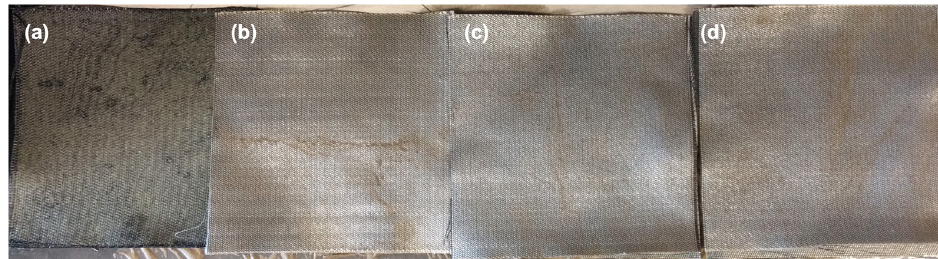
Figure 8. Woven geotextiles after the filtration process: ( a ) TE-GMW70—AOS: 700 µm, ( b ) TE-GMW35 s layer—AOS: 425 µm, ( c ) TE-GMW35 third layer—AOS: 425 µm and ( d ) TE-GMW35 fourth layer—AOS: 425 µm.